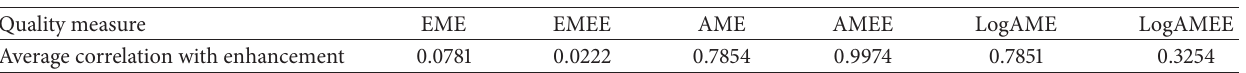
Table 1: Average Pearson correlation for all 1932 images from MIAS database of mammograms (322 images with 6 enhanced versions of each image). The AMEE measure shows the best performance between the measures we tested.